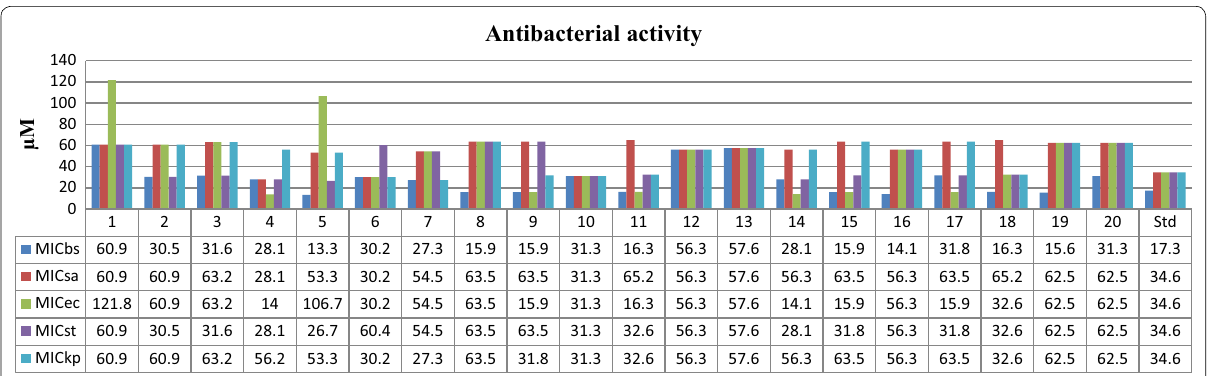
BS: Bacillus subtilis ; SA: Staphylococcus aureus ; EC: Escherichia coli ; ST: Salmonella typhi ; KP: Klebsiella pneumoniae ; AN: Aspergillus niger ; CA: Candida albicans